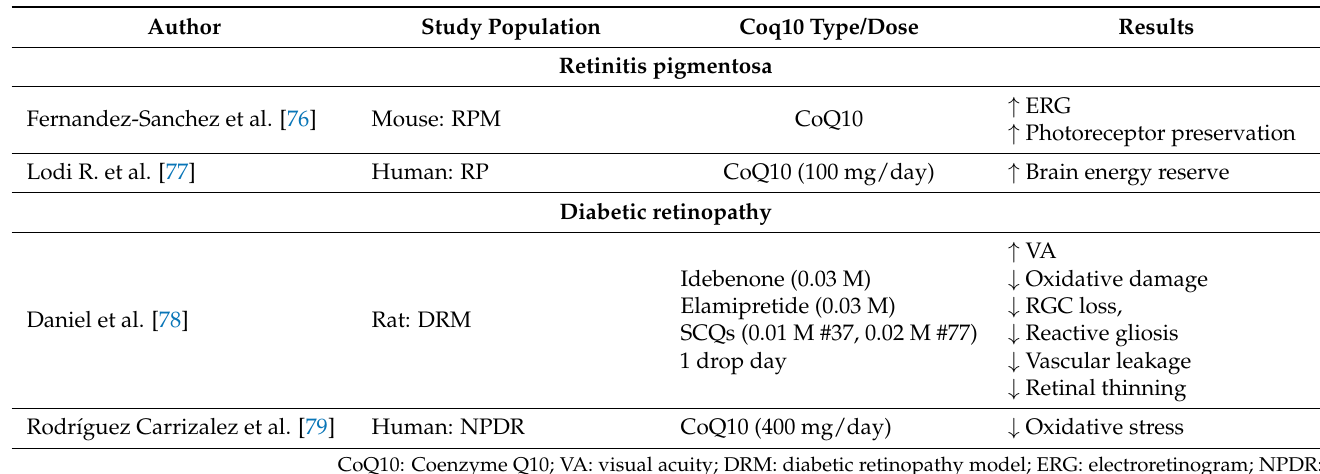
Table 6. A summary of articles that relate CoQ10 to RP and